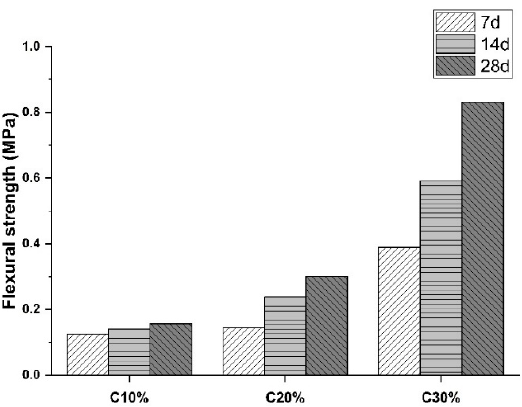
Figure 5. Flexural strength enhancement of control group (Note: C represents Portland cement).